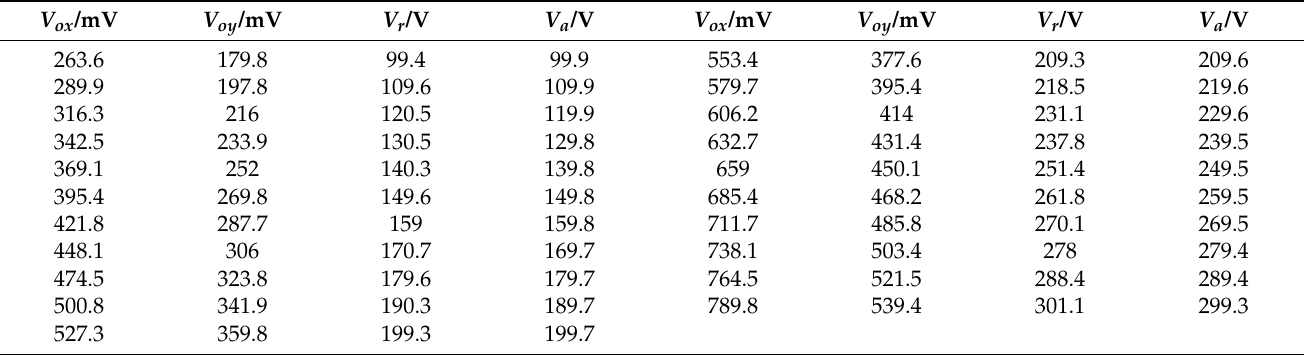
Table 4. Reconstitution accuracy test